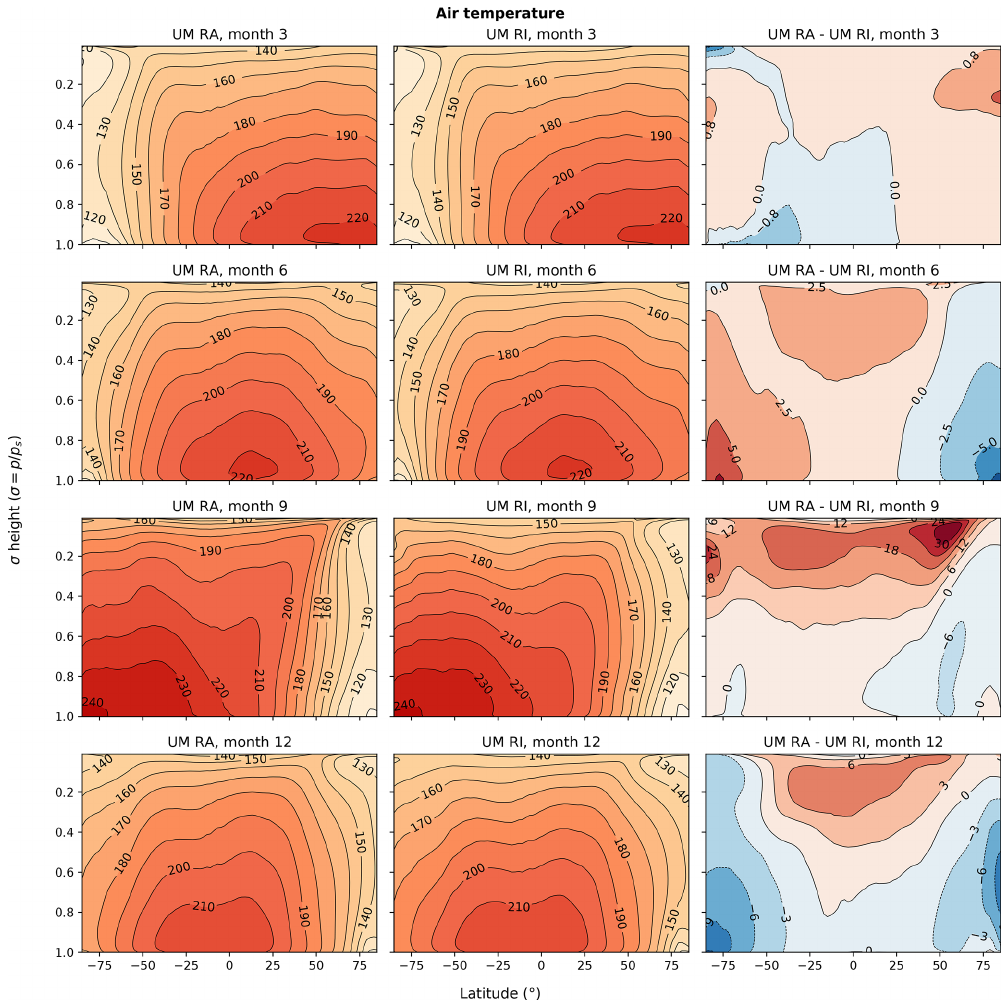
Figure A3. Zonal mean air temperature (K) across four seasons within the Martian year. For each month, the time average is taken of all sols within that month. The RA dust scenario is shown on the left, the RI dust scenario in the centre and the differences between scenarios on the right. Colour scales in the left-hand and right-hand plots are matched across all months and between scenarios, with contour intervals of 10K. The contours in the difference plots are not matched due to the varying intensity of the difference between